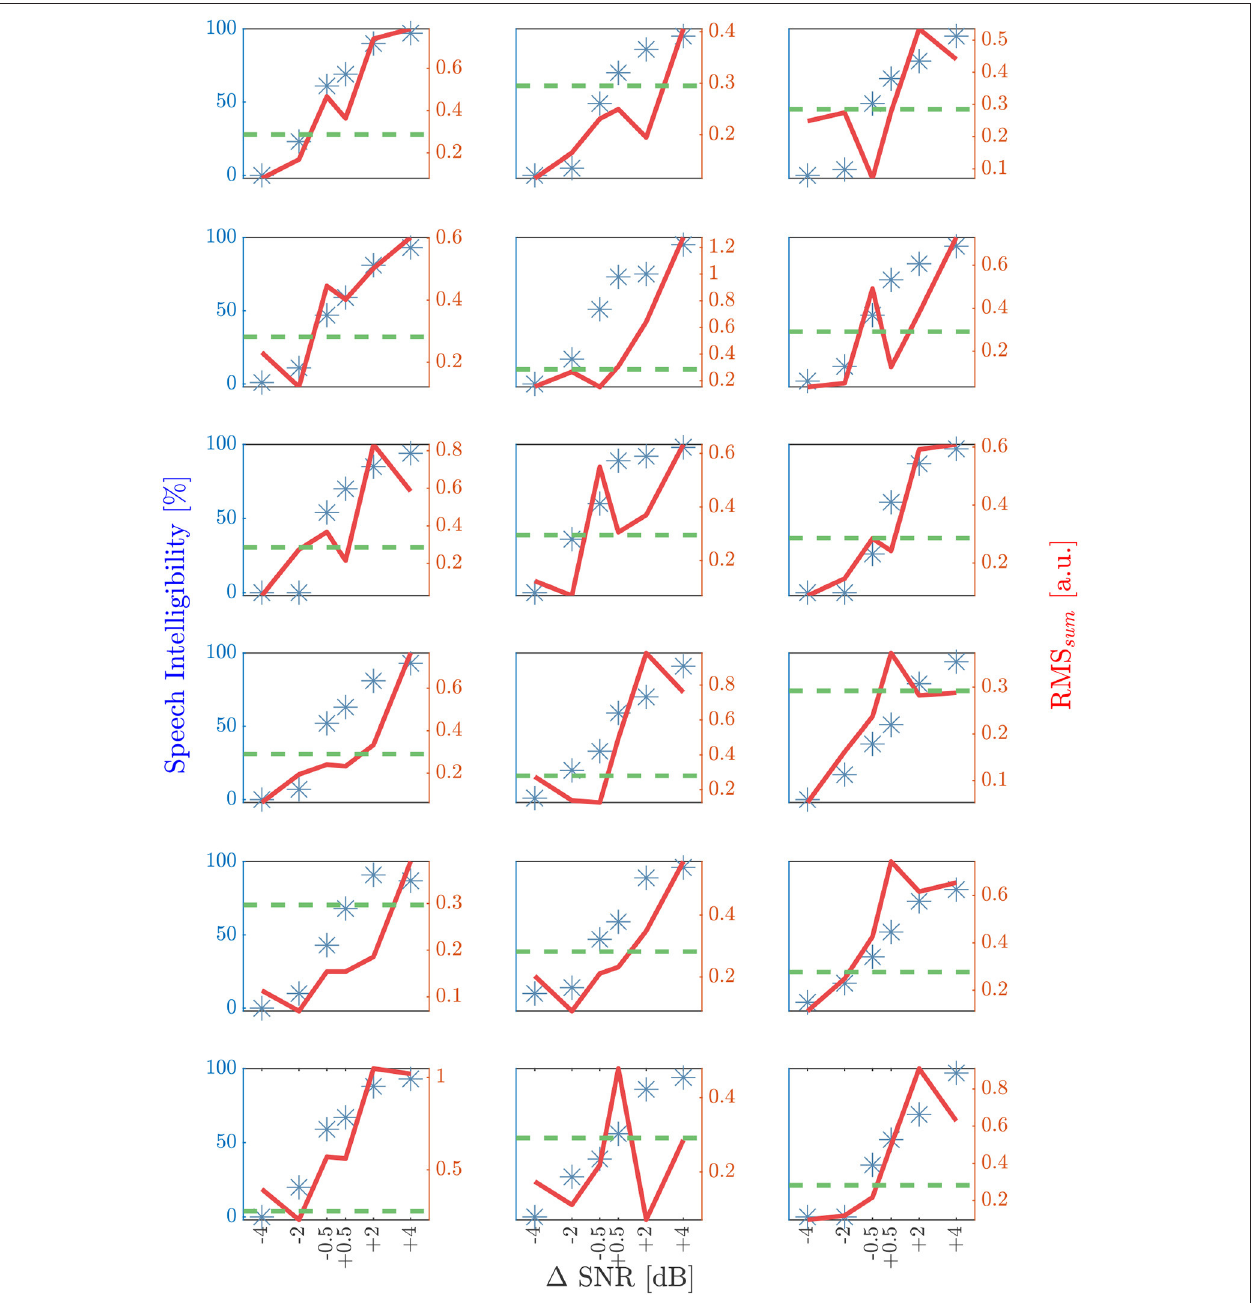
FIGURE 7 | Results of the speech intelligibility and RMS sum ( ρ = 0.71; p > 0.001) for the six different 1 SNR conditions for each subject. A 1 SNR of zero dB corresponds to the behavioral SRT 50 . Blue stars are indicating the speech intelligibility in percentage and the red solid line shows the corresponding RMS sum value. Green dashed horizontal line is representing the RMS 50 , determined by using a leave one out method per subject. The first intersection point with increasing RMS sum and increasing SNR is located in a range of ± 1 dB for seven and ± 2 dB with respect to behavioral SRT 50 for 16 out of 18 subjects.